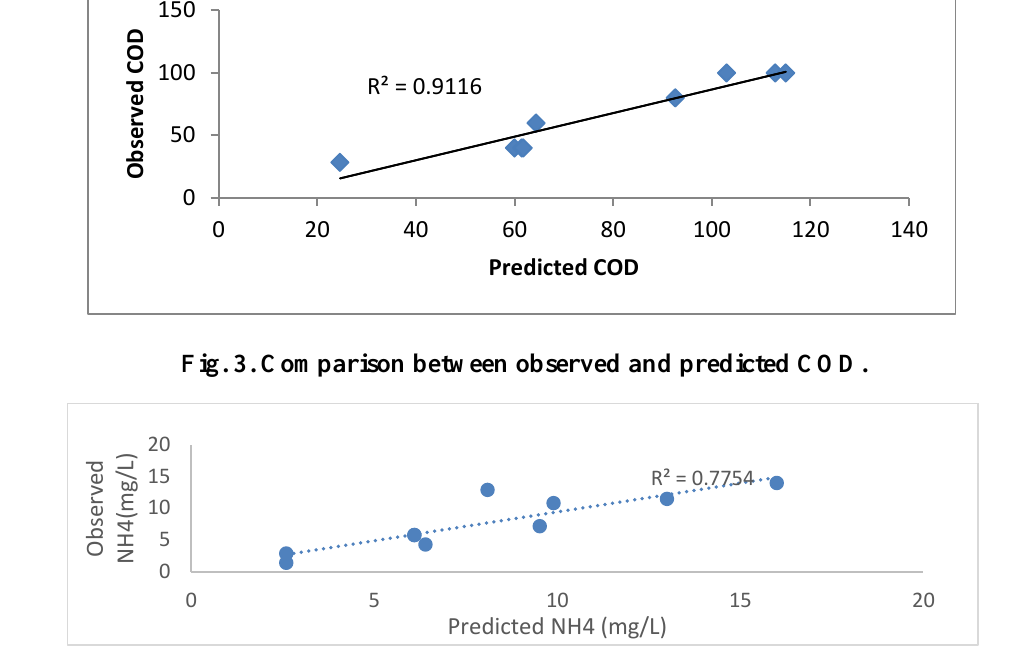
Fig. 4. Comparison between observed and predicted